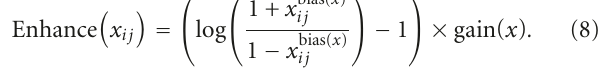
curve can be further dynamically adjusted. Figure 10(a) plots the inverse hyperbolic tangent func- tion over the domain − 1 < x < 1 with a shift to 0 < x < 1 domain in Figure 10(b).